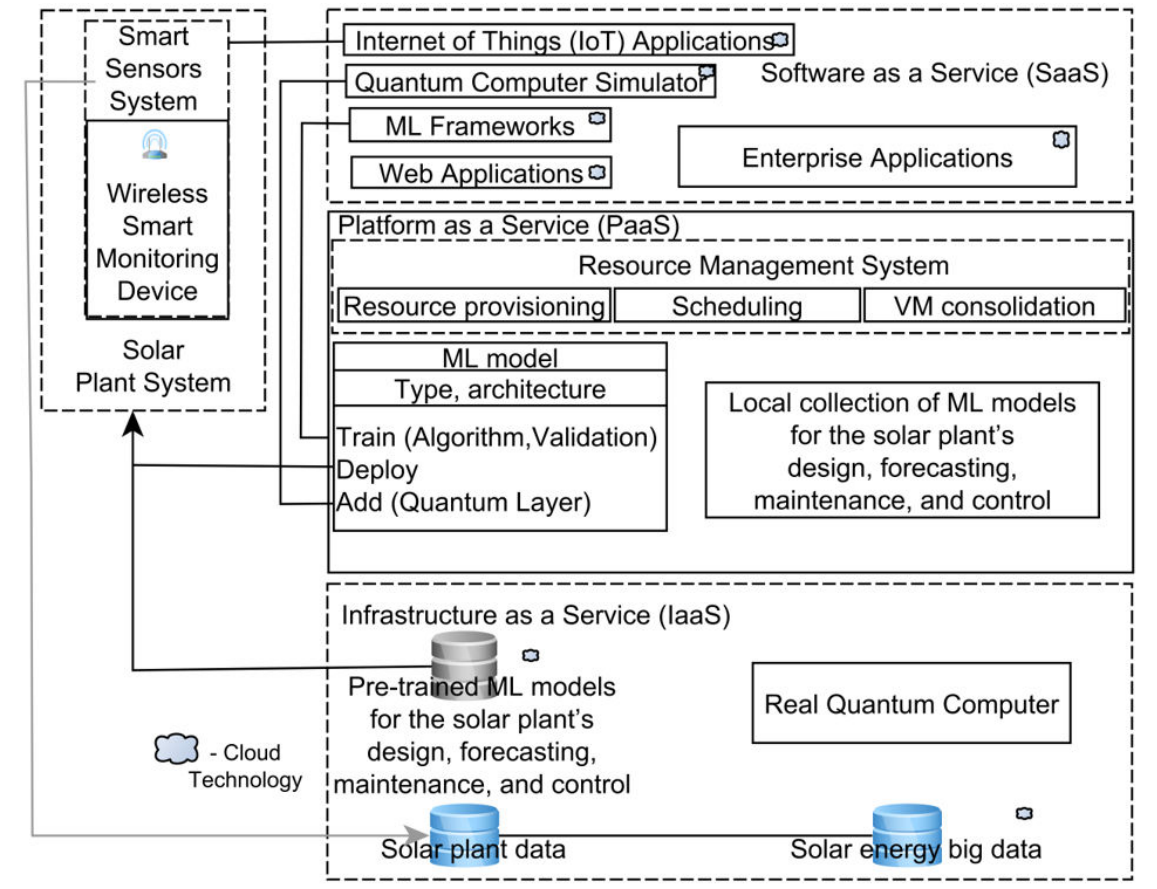
Figure 11. Smart solar plant